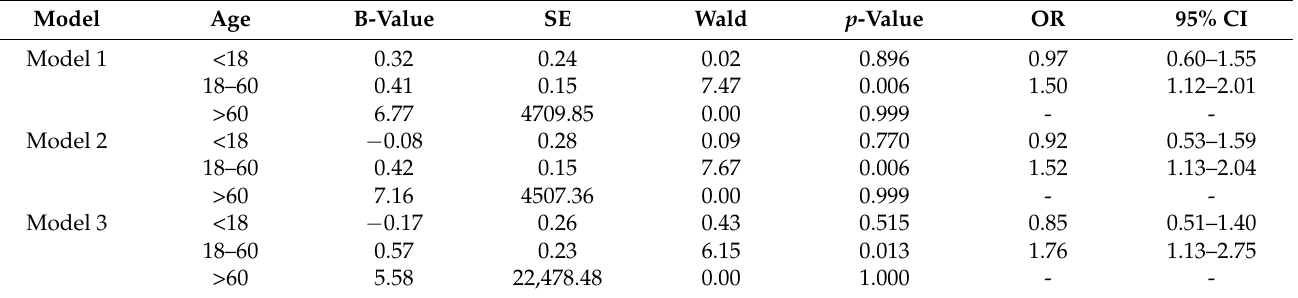
Table 3. Multivariate logistic regression analysis of IL-6 in the different age groups of DPOAE